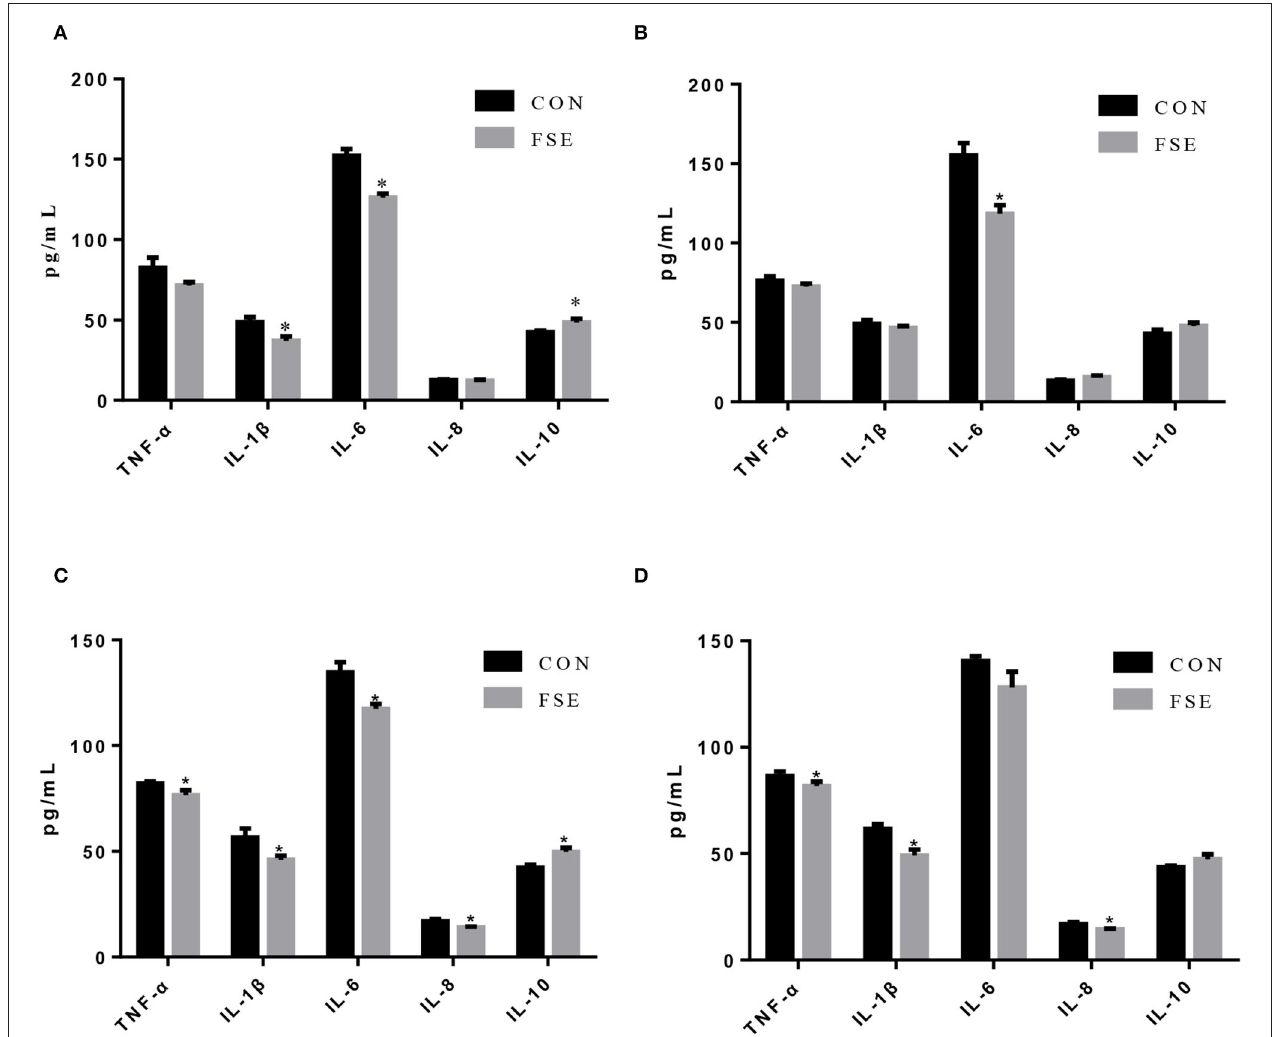
FIGURE 5 | Effects of Forsythia suspensa extract on inflammatory cytokines in serum of suckling piglets. CON, control treatment; FSE, Forsythia suspensa extract treatment. (A) Inflammatory cytokines in serum of piglets at farrowing; (B) Inflammatory cytokines in serum of piglets on d 7 of lactation. (C) Inflammatory cytokines in serum of piglets on d 14 of lactation. (D) Inflammatory cytokines in serum of piglets at weaning. All values are expressed as means ± SEM ( n = 6). * P <